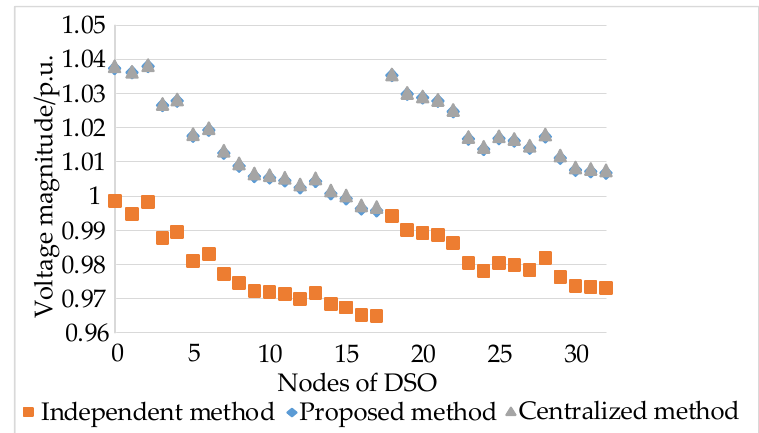
Figure 5. Voltage distribution of D26 with different methods on test case 1. Table 5. Power output of generators in TSO with different methods on test case 1.